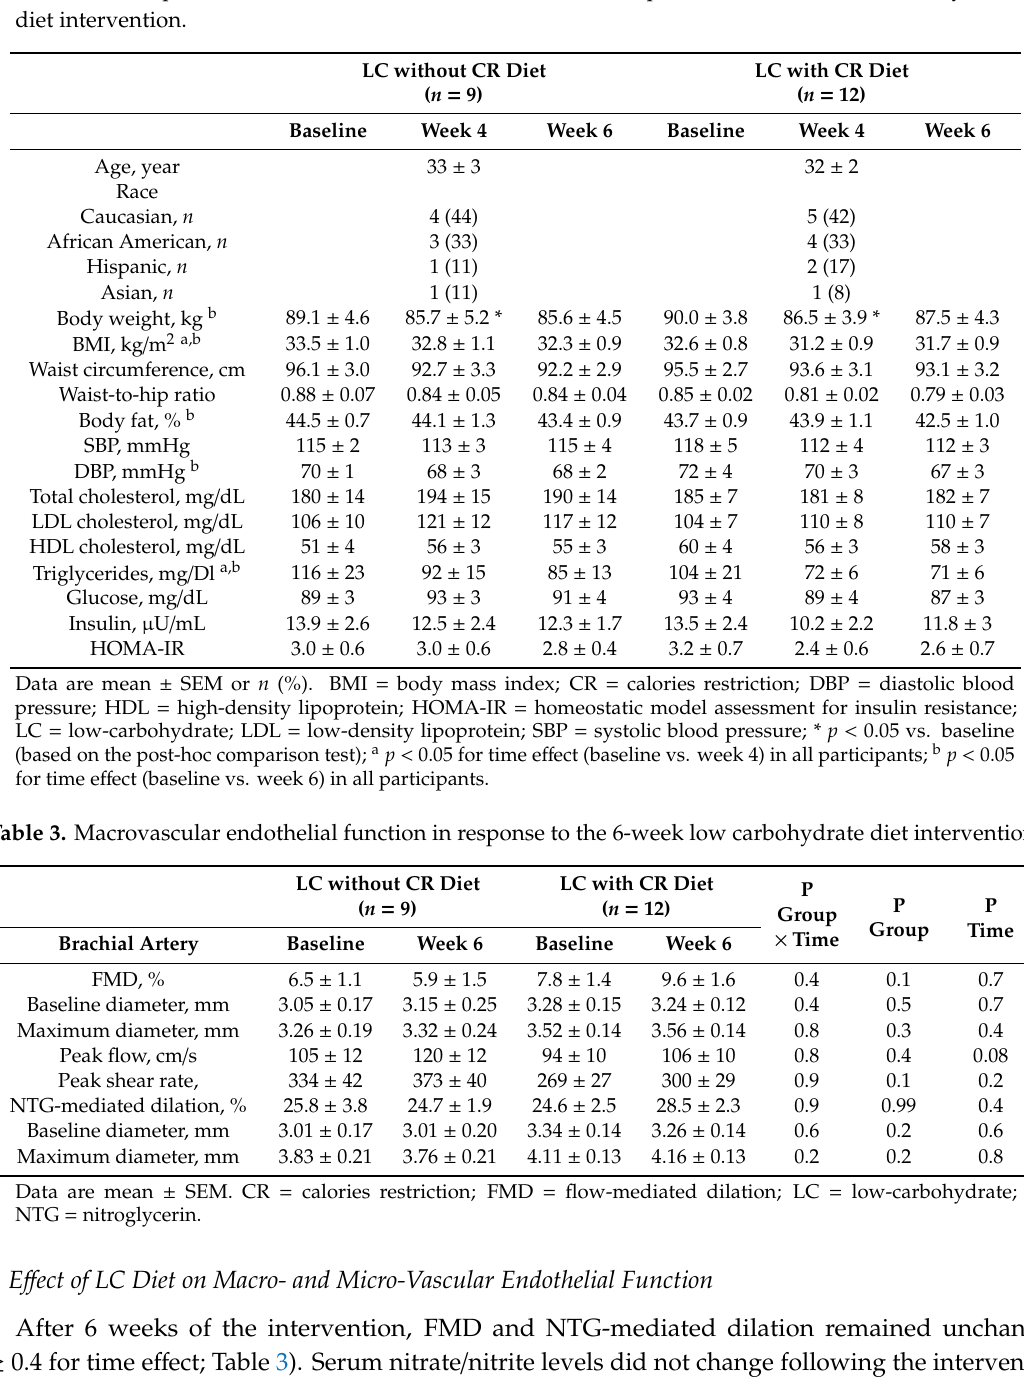
Table 2. Participant characteristics and cardiovascular risks in response to the 6-week low carbohydrate diet intervention. LC without CR Diet LC with CR Diet ( n = 9) ( n = 12) Baseline Week 4 Week 6 Baseline Age, year 32 ± 2 Race Caucasian, n 4 (44) 5 (42) African American, n 3 (33) 4 (33) Hispanic, n 1 (11)